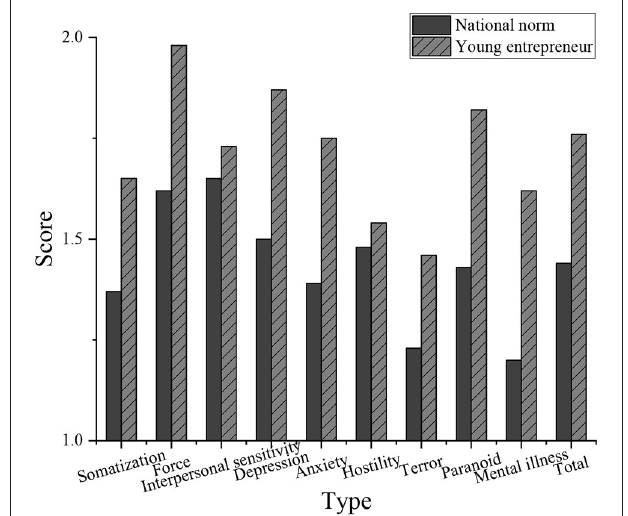
FIGURE 6 | Trend forecast results.